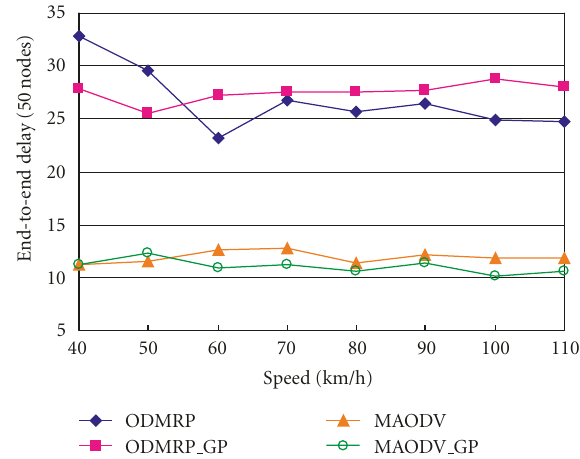
Figure 20: End-to-end delay versus mobility speed (50 nodes).